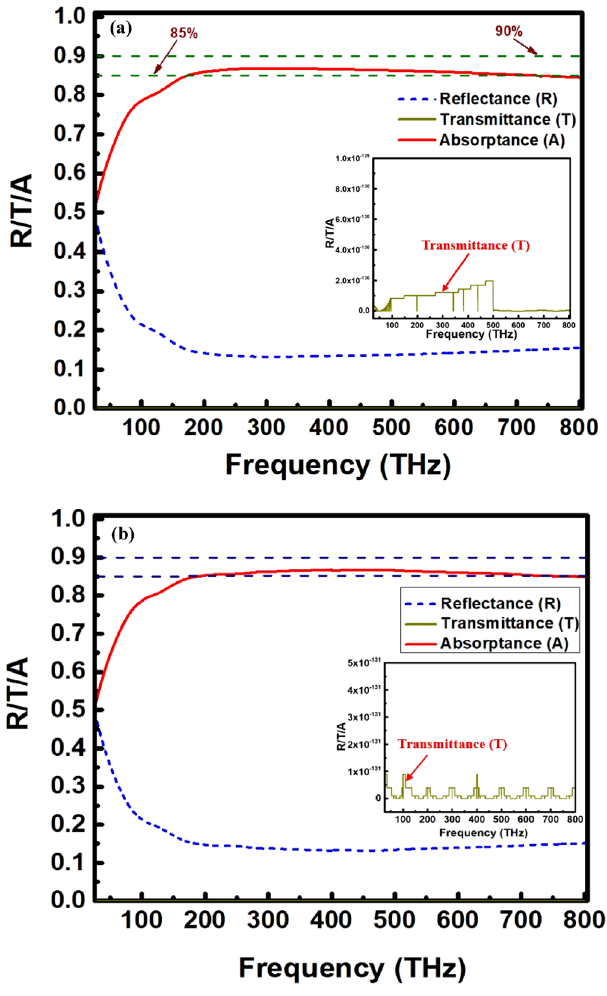
Figure 3. Reflectance, transmittance and absorption spectrums of proposed ( a ) unit-cell and ( b ) 2-D periodic array (3 × 3 unit cells) broadband antenna under normal incidence of plane wave: The top metal (Ni) and substrate (SU8) are patterned and shaped in a groove like structure. The inset images are the magnified view of the transmittance